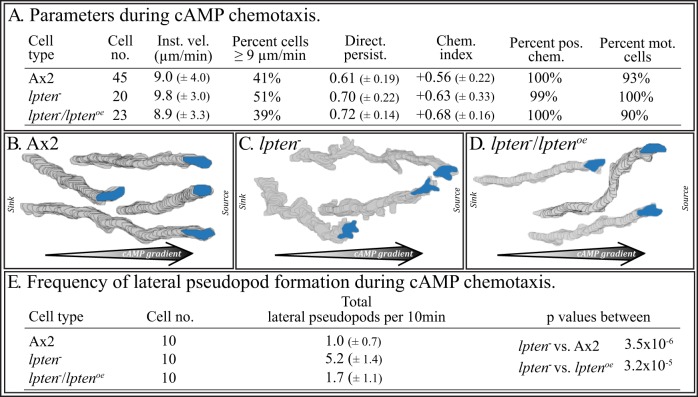

lpten− cells undergo normal chemotaxis in the low cAMP concentration gradient generated in the estimated for that of the natural wave.The gradient was generated in BSS buffer, in which K+ and Na+ are the facilitating cations. lpten− cells, however, are still defective in suppressing lateral pseudopod formation. A. 2D motility and chemotaxis parameters, assessed by 2D-DIAS software of Ax2, lpten− and lpten−/lptenoe cells undergoing chemotaxis in a low cAMP concnetration gradient. B, C, D. 2D-DIAS-reconstructed perimeter tracks of representative cells. The large arrows at panel bottoms denote the net direction of the increasing cAMP gradient. “Sink”, trough with buffer alone; “Source”, trough with buffer plus 1 µM cAMP. E. 2D analysis of lateral pseudopod formation. Direct. Persist, directional persistence; chem. index, Chemotactic Index (CI); Percent pos. chem., percent cells with a positive CI. See legend to Figure 2 for additional definitions and details. Parameters are defined in Table S2.